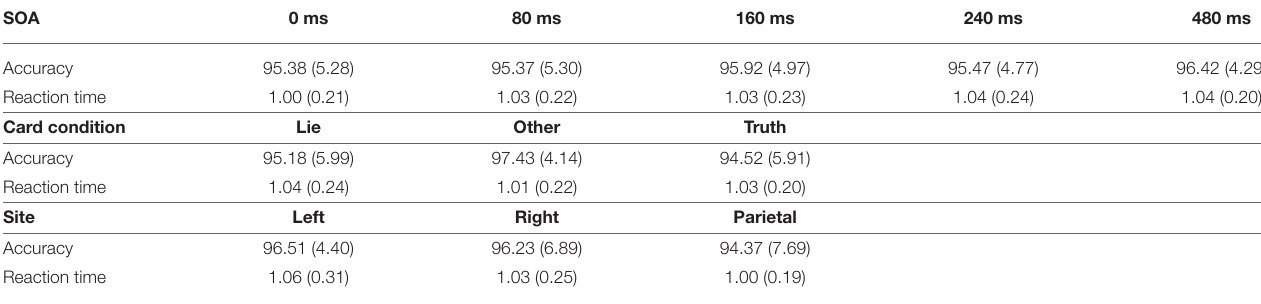
TABLE 1 | Mean percent accuracy and reaction time (in seconds) and their standard deviation for each SOA, card condition, and site.